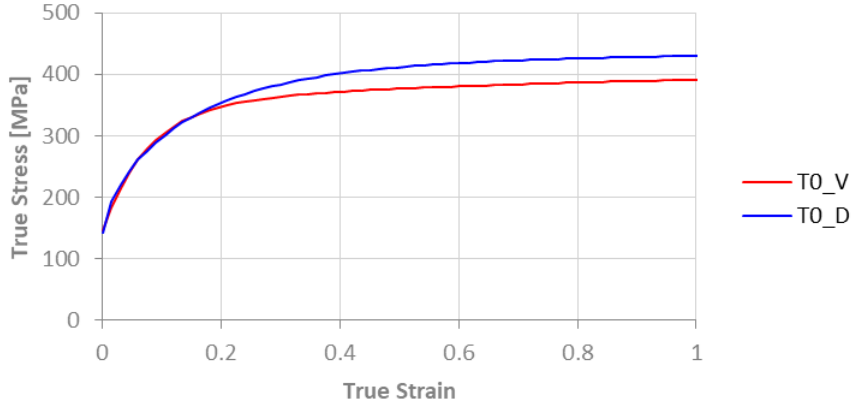
Figure 11. Voce-type and DDR model stress–strain curves for a 100% deformation.